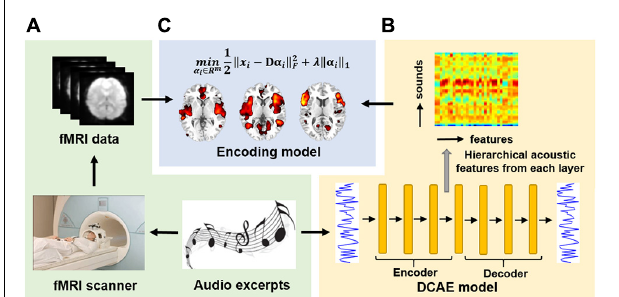
FIGURE 1 | The schematic illustration of the study. (A) fMRI acquisition using naturalistic auditory excerpts as stimuli. (B) Hierarchical feature representation of the naturalistic auditory stimuli via an unsupervised DCAE model. (C) Hierarchical acoustic features were correlated to fMRI brain activities using an encoding model based on LASSO to infer hierarchical auditory representation in the